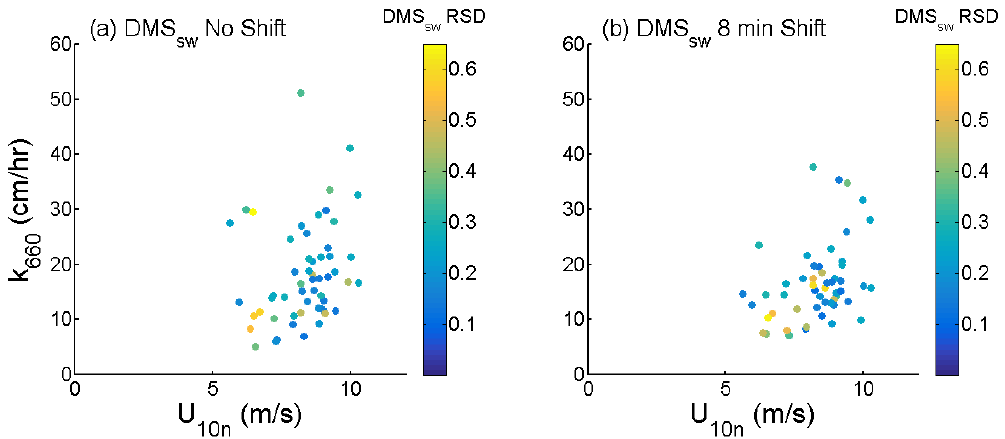
Figure 8. 10min average DMS gas transfer coefficients ( k 660 ) vs. mean horizontal wind speed ( U 10 n ) during the south–north transect into B1 waters. Data are colored by the relative standard deviation (RSD) for corresponding DMS sw (see text). (a) Gas transfer velocities calculated before adjustment of DMS sw to account for decoupling from the flux footprint. (b) k 660 calculated using seawater DMS shifted by 8min to account for the lag between measured flux and (cid:49)C (see